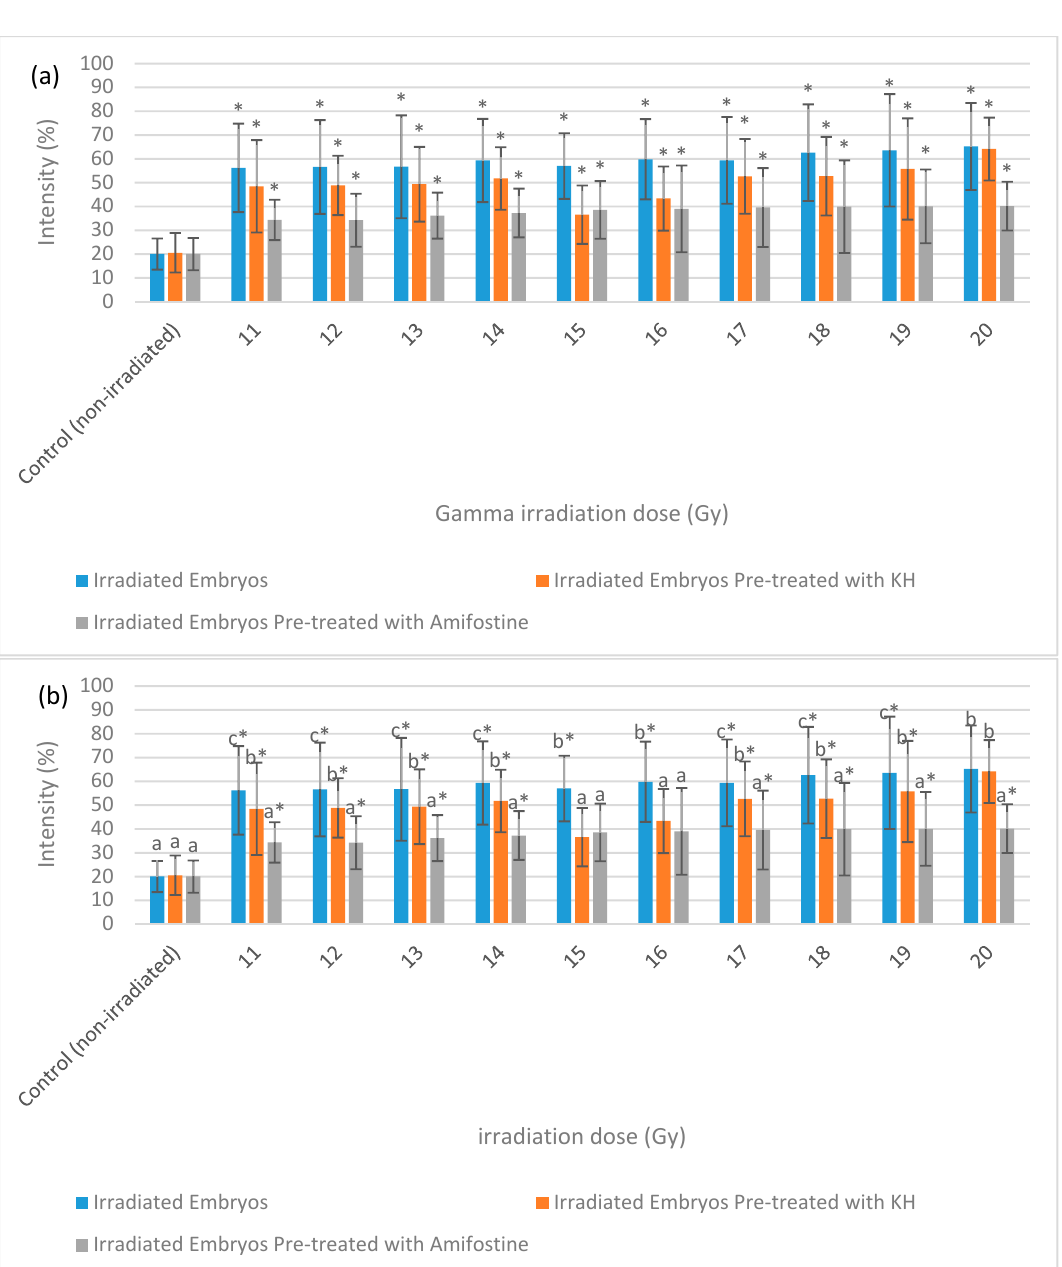
Figure 7. Expression of γ‐ H2AX in non ‐ irradiated and irradiated zebrafish embryos. ( a ) Control without any treatment (non ‐ irradiated); ( b ) control pre ‐ treated with KH (non ‐ irradiated); ( c ) control pre ‐ treated with amifostine (non ‐ irradiated); ( d ) untreated embryos irradiated at 11 Gy; ( e ) embryos pretreated with KH and irradiated at 11 Gy; ( f ) embryos pretreated with amifostine and irradiated at 11 Gy; ( g ) untreated embryos irradiated at 15 Gy; ( h ) embryos pretreated with KH and irradiated at 15 Gy; ( i ) embryos pretreated with amifostine and irradiated at 15 Gy; ( j ) untreated embryos irradiated at 20 Gy; ( k ) embryos pretreated with KH and irradiated at 20 Gy; ( l ) embryos pretreated with amifostine and irradiated at 20 Gy.